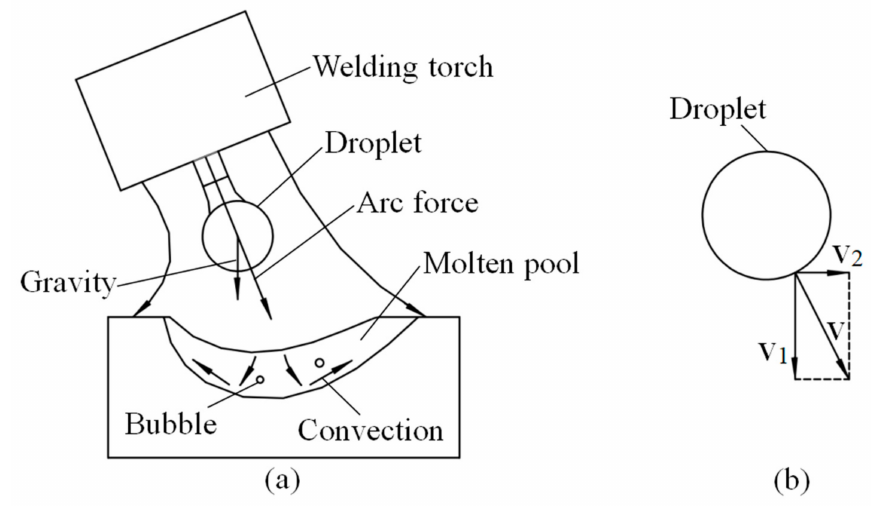
Figure 9. Schematic diagram of the droplet impact ( a ) droplet force diagram; ( b ) droplet movement